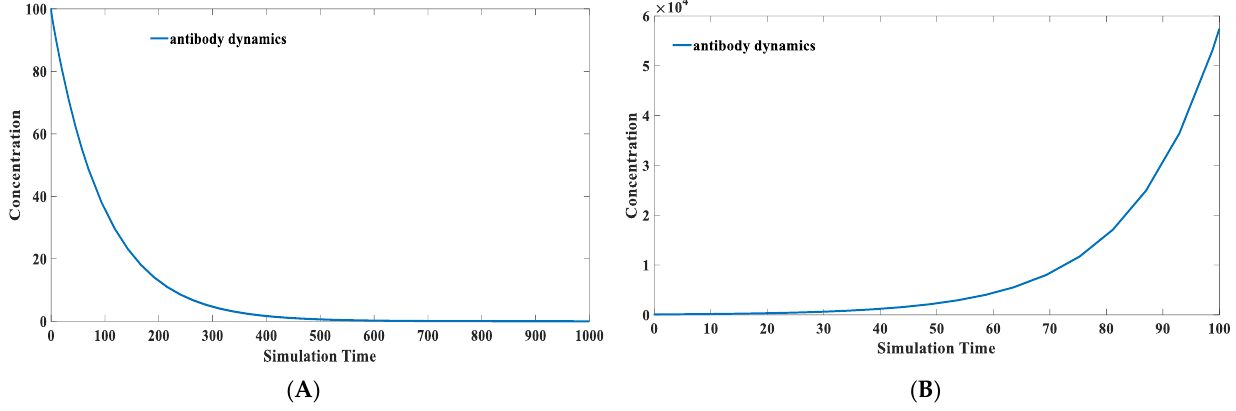
Figure 4. Antibody dynamics modeling with different 𝑘 7 values. ( A ) One scenario where environ- mental antigen-like substances do not trigger antibody growth. As shown in ( A ), the antibody does not engage proliferation due to the presence of environment antigen-like molecules. The parameter set we used is: x (0) = 0, y (0) = 100, z (0) = 0, p (0) = 1,000,000, 𝑘 1 = 0.1, 𝑘 2 = 1 × 10 −5 , 𝑘 −2 = 1 × 10 −14 , 𝑘 3 = 1, 𝑘 4 = 2, 𝑘 5 = 0.02, 𝑘 6 = 0.02, 𝑘 7 = 1 × 10 −8 , 𝑘 −7 = 1 × 10 −14 . ( B ) One scenario where environmental antigen-like substances do trigger antibody proliferation. As shown in ( B ), the antibody does engage proliferation due to the presence of environment antigen-like molecules. The parameter set we used is: x (0) = 0, y (0) = 100, z (0) = 0, p (0) = 1,000,000, 𝑘 1 = 0.1, 𝑘 2 = 1 × 10 −5 , 𝑘 −2 = 1 × 10 −14 , 𝑘 3 = 1, 𝑘 4 = 2, 𝑘 5 = 0.02, 𝑘 6 = 0.02, k 7 = 1 × 10 −7 , 𝑘 −7 = 1 × 10 −14 . The antibodies might significantly increase when the environmental antigenic substances bind strongly with them. This always induces allergic reac- tions.